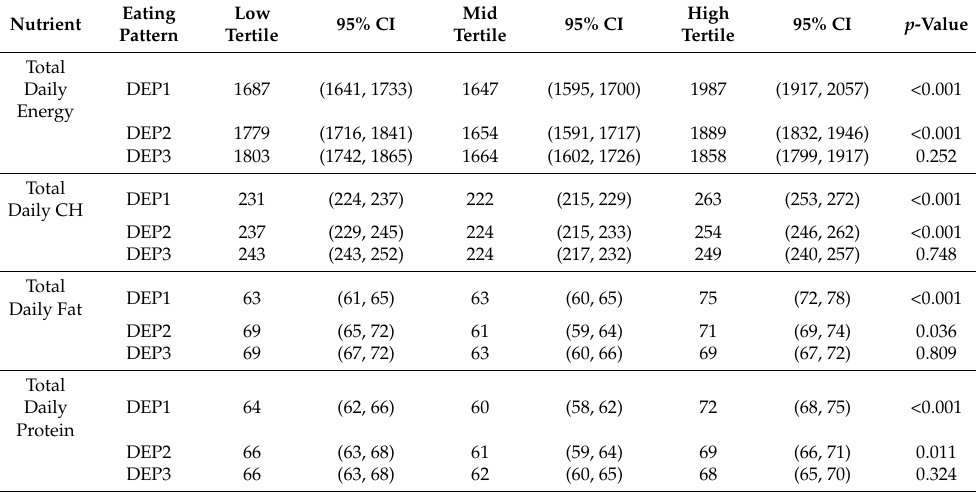
Table 2. The tertile estimates and 95% confidence intervals by DEP for total daily energy and carbohydrate, fat, and protein intake. The p -values are calculated based on the linear association with the respective continuous DEP score.